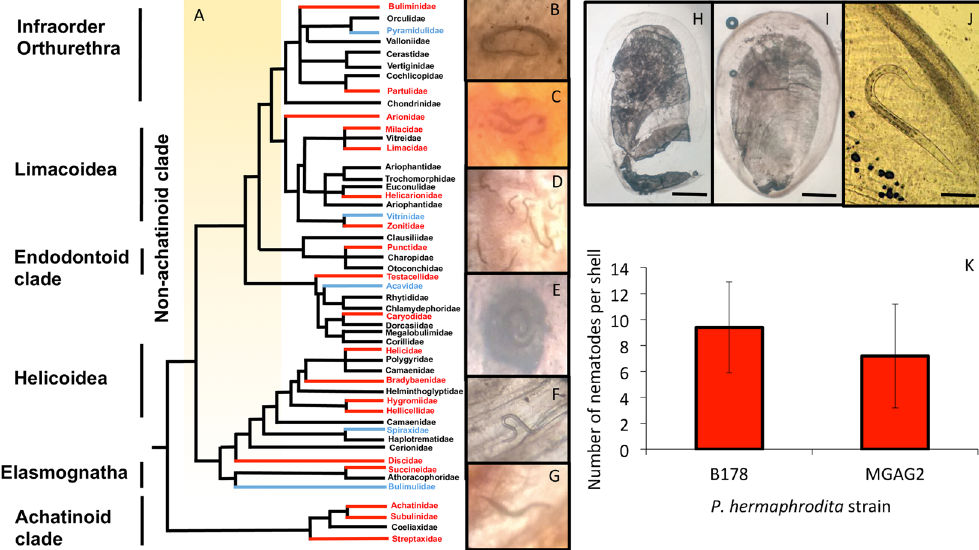
Figure 4. Nematode encapsulation is evolutionary conserved across the Stylommatophora. The evolutionary relationship between members of the Stylommatophora has been debated for over 100 years 35 . A representative molecular phylogeny 5 which is in agreement with morphological classifications 36 was used ( A ). Shells from families had nematodes present (red) or absent (blue) or not examined (black). For exact number of shells examined and numbers of nematodes present see Table S2. Nematodes were found in the shells of the following snails species: Partula rosea ( B ), Gudeoconcha sophiae ( C ), C. aspersum ( D ), Helicostyla intorta ( E ), Succinea putris ( F ) and Glessula inornata ( G ). As well as snails, slugs ( D. panormitanum ) were shown to encapsulate and kill parasitic nematodes in their internal shell. Uninfected D. panormitanum ( H ) do not have nematodes present but when infected with two P. hermaphrodita strains (B178 and MGAG2) nematodes are found